Question: Provide a one-line summary of what is displayed.
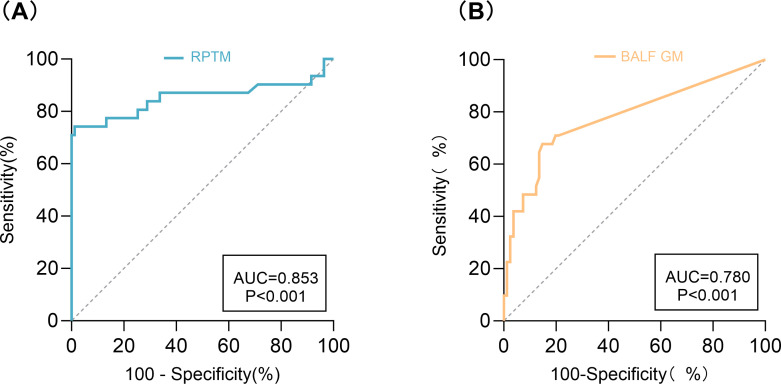
Answer: (A) Receiver operating characteristic (ROC) curve analysis for determining the optimal RPTM cut-off value to distinguish between the two groups. (B) ROC curve analysis for determining the optimal BALF GM cut-off value to distinguish between the two groups. mNGS, metagenomic next-generation sequencing; RPTM, reads per ten million; BALF, bronchoalveolar lavage fluid; GM, galactomannan.